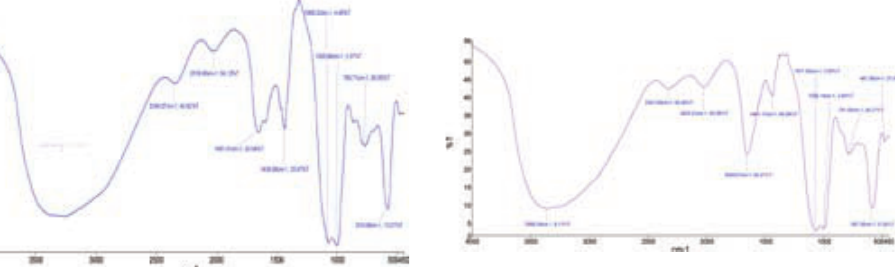
Figure 8: Infrared spectrum of goat A 3 struvite bands at 3360, 1441, 2321, 1654 and 1000.14 cm